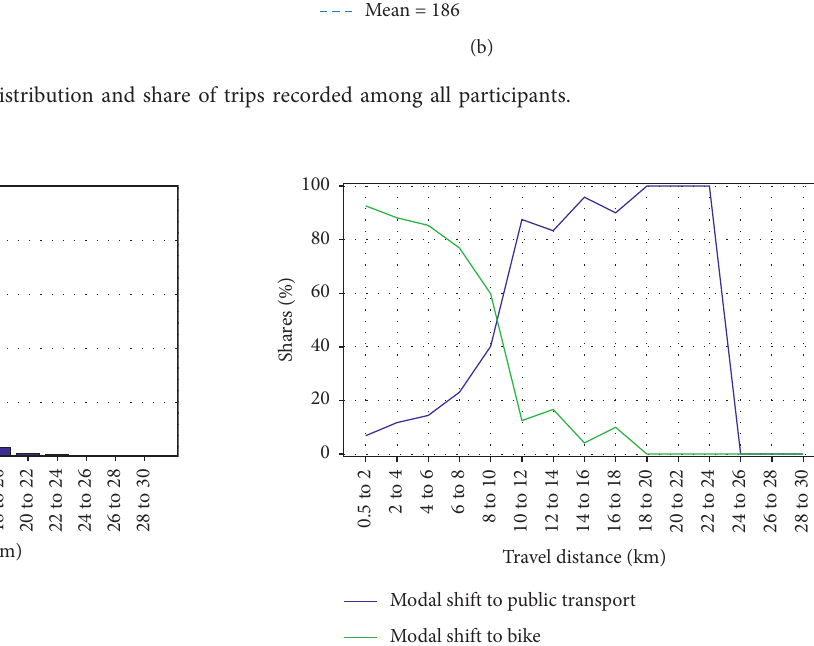
Figure 10: Share of each group of low-carbon modes in potential time-relevant modal shift from car. (a) To bike. (b) To public